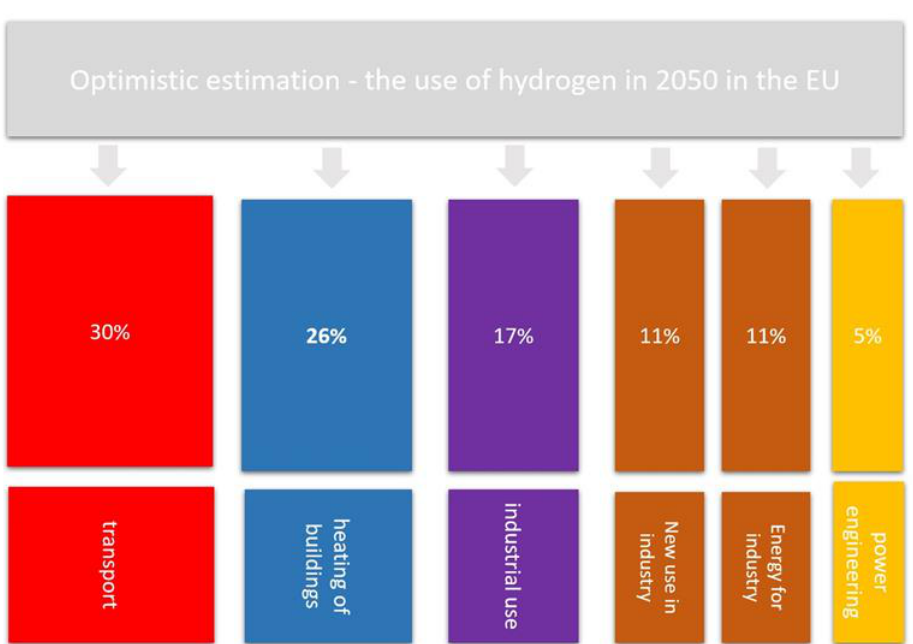
Figure 3. Optimistic hydrogen performance data in 2050 [55].